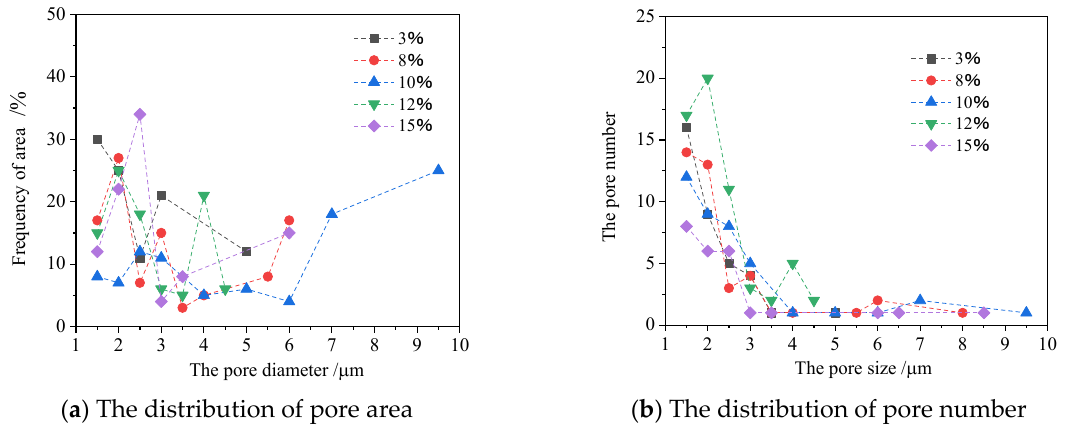
Figure 7. Microstructure characteristics of SN-1 under different absorption conditions.